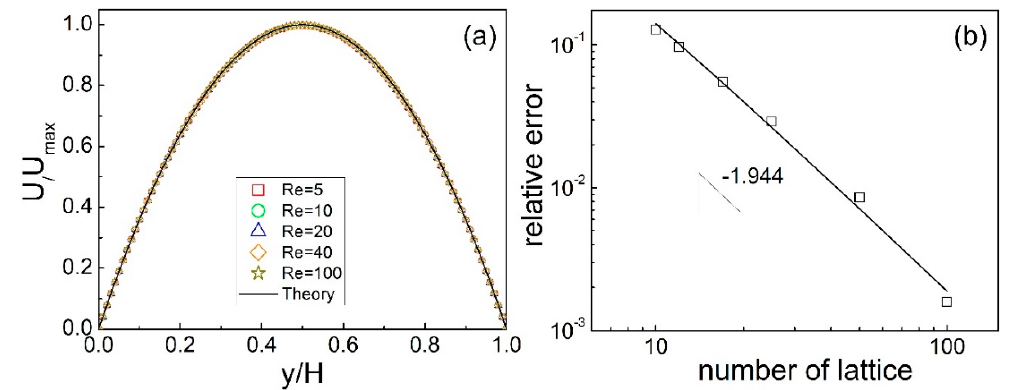
Figure 6. ( a ) Normalised velocity profile for 2D Poiseuille flow with channel size 101 × 101. ( b ) The relative error of the fluid velocity as a function of the lattice resolution.